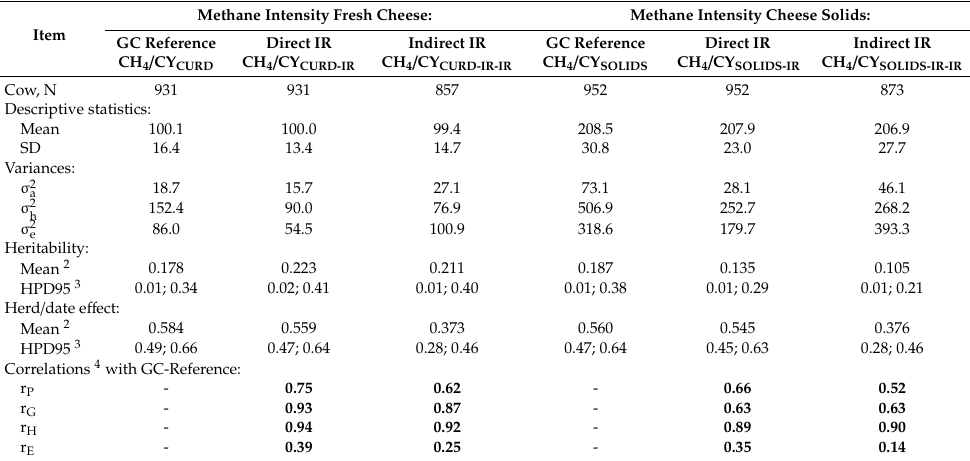
Table 3. Estimates of additive genetic ( σ 2 a ), herd / date ( σ 2 ), and residual ( σ 2 e ) variances, heritability, h and herd / date e ff ect of GC reference values based on GC FA profile, and of direct IR and indirect IR predictions 1 of methane intensity fresh cheese and cheese solids based on milk FTIR spectra; and additive genetic (r G ), herd (r H ), residual (r E ), and phenotypic (r P ) correlations between GC reference and IR-predicted methane emission traits 1